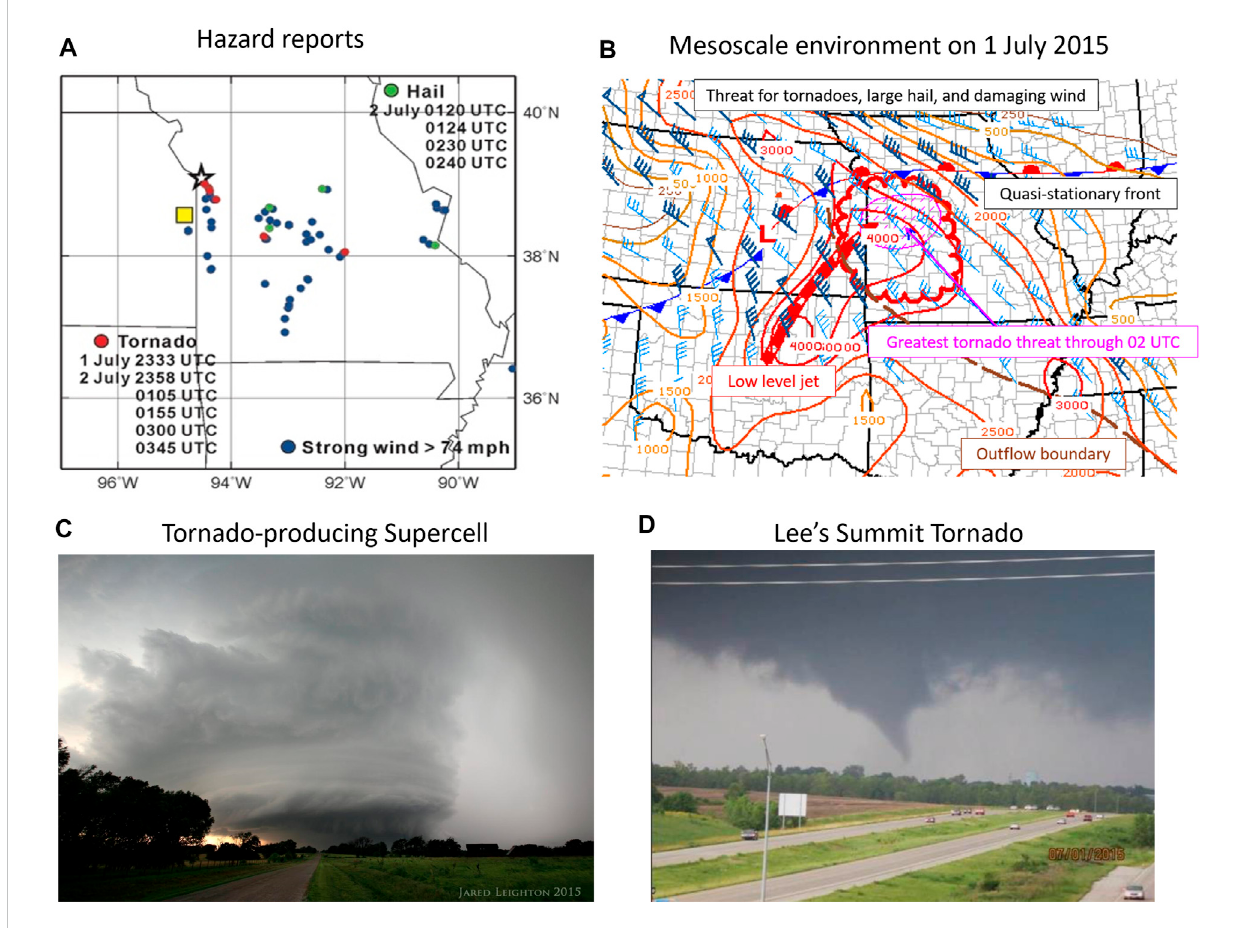
FIGURE 1 (A) The mesoscale environment on 1 July 2015, adapted from the mesoscale discussion #1274 issued by NOAA Storm Prediction Center (https:// www.spc.noaa.gov/products/md/2015/md1274.html). LLJ denotes low-level jet. (B) The reports of large hail, tornado, and strong winds from the NOAA StormPredictionCenter (SPC).Photosof (C) thetornado-producing supercell(photo byJared Leighton, http://slightrisk.net/chase_2015/july_1), (D) the tornado in Lee ’ s Summit (photo by Christopher